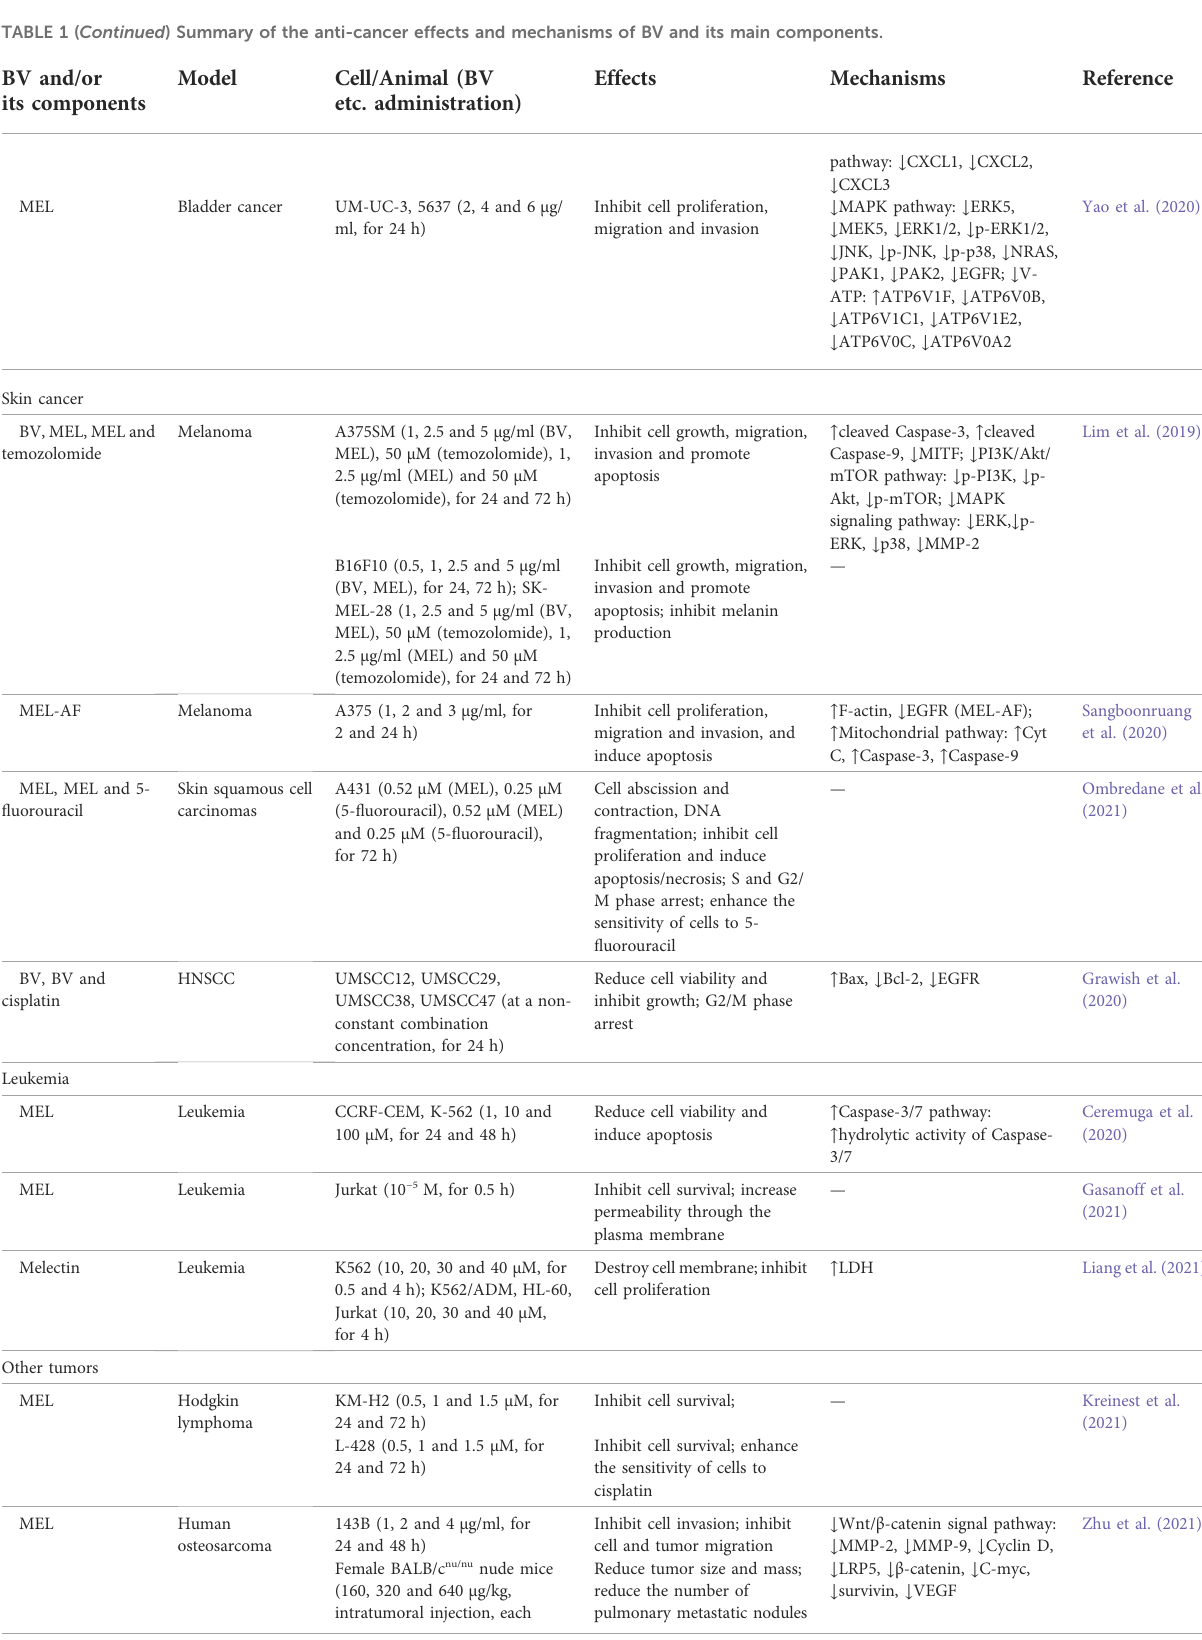
TABLE 1 ( Continued ) Summary of the anti-cancer effects and mechanisms of BV and its main